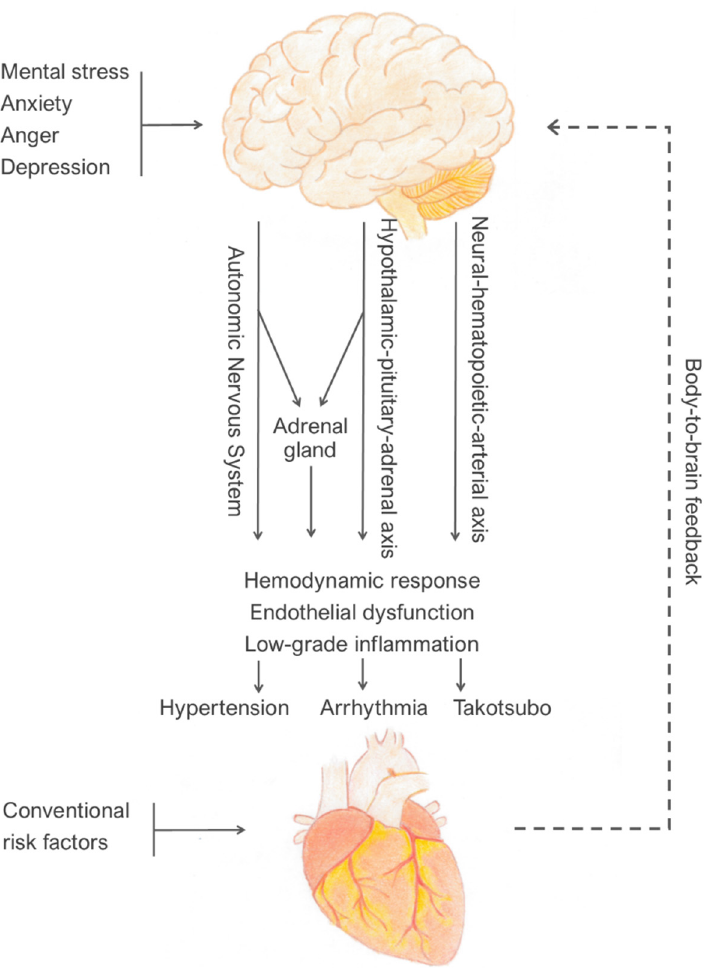
Figure 1. Schematic model of the mechanisms that translate negative emotion into CV disease. The brain response to mental stress involves activation of autonomic nervous system, hypothalamic– pituitary–adrenal axis, and neural–hematopoietic–arterial axis, resulting in pathophysiological effects that trigger CV events (brain-to-body). In turn, these effects modulate the brain response to stress (body-to-brain).